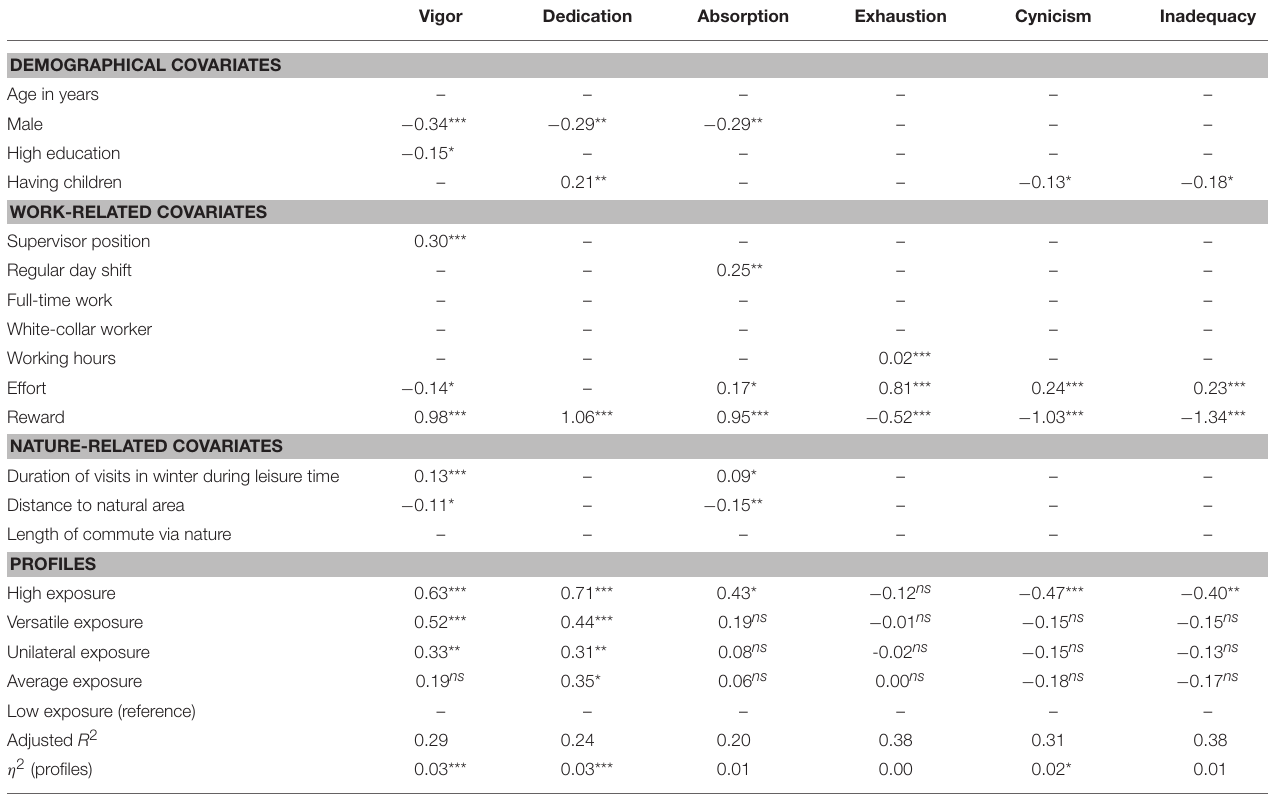
TABLE 7 | The final results of six separate analyses of covariance with significant covariates: parameter estimates (Unstandardized B) are reported in order to show the direction of the